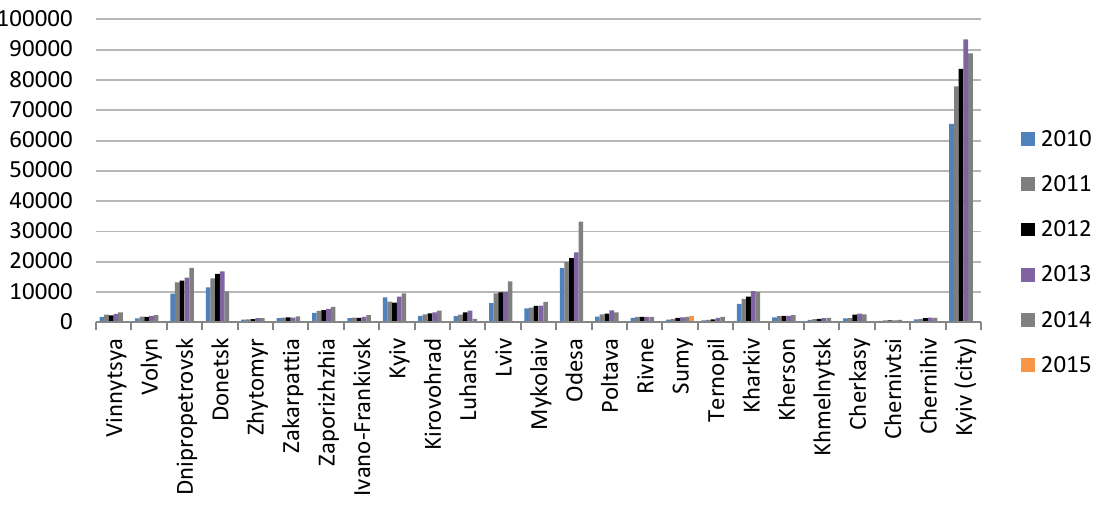
Fig. 12. The volume of services sold by the services sector enterprises to enterprises by regions in 2010 – 2015, million UAH (based on data of the State Statistics Service of